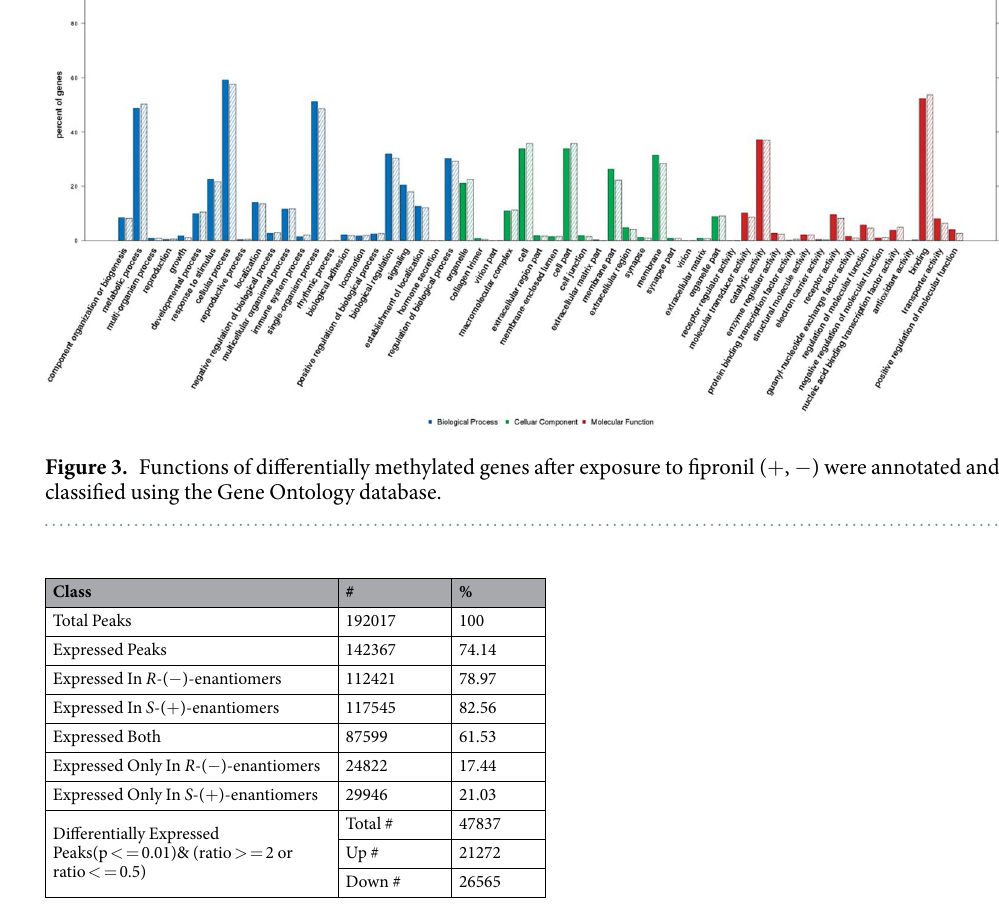
Table 2. Statistics associated with expressed peaks of global DNA methylation in R -( − )-fipronil and S -( + )- fipronil.